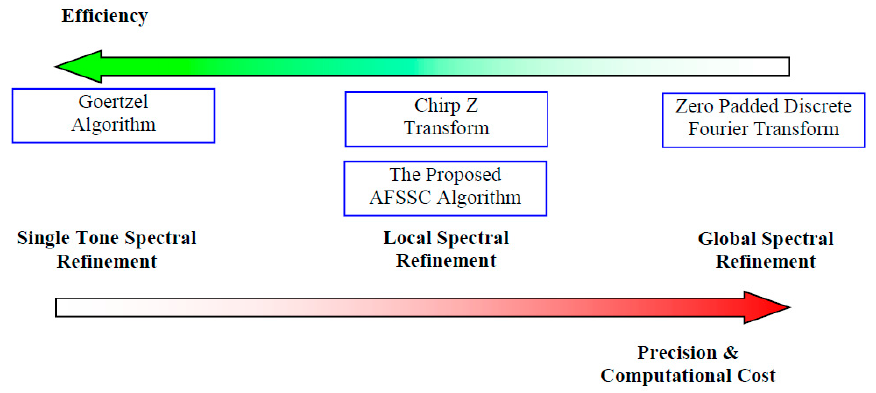
Figure 14. Pros and cons of some classical spectral refinement techniques with the proposed AFSSC algorithm.